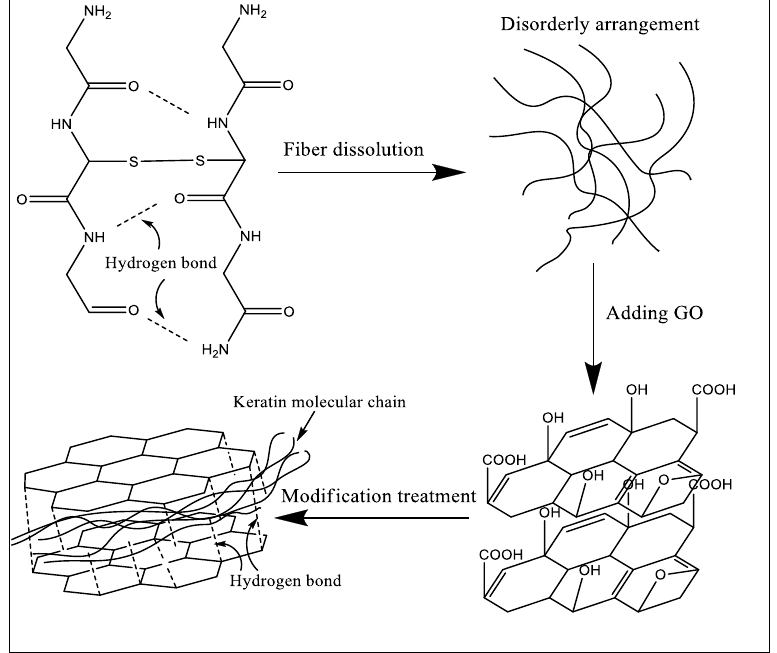
Figure 7. The mechanism of graphene oxide modification of keratin.